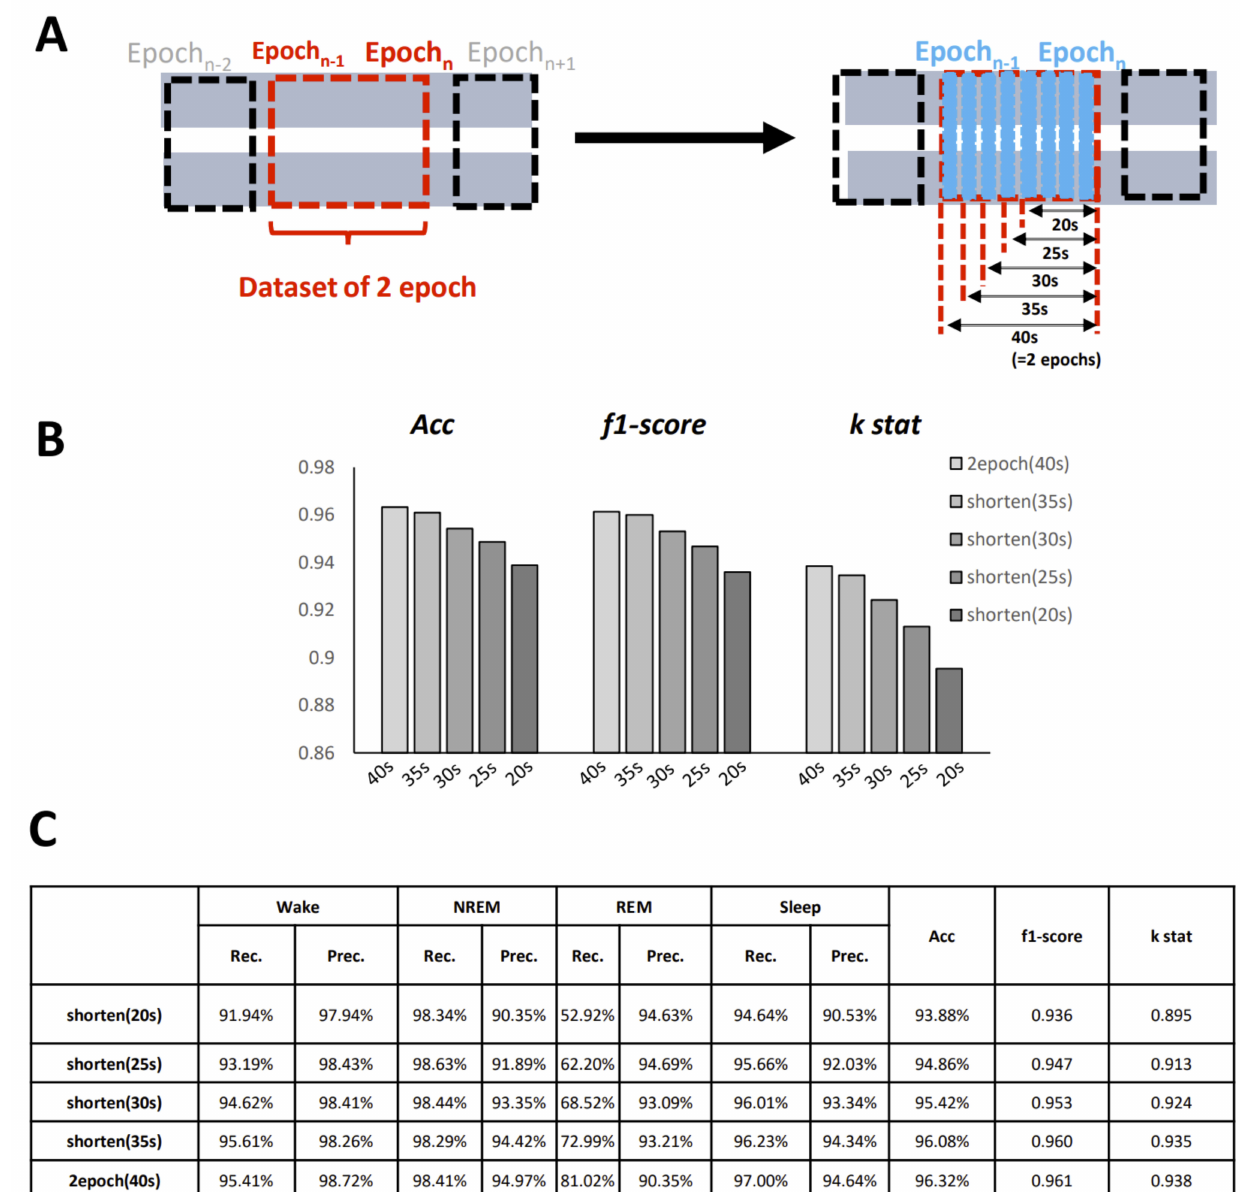
Figure 6. Effect of epoch length on the performance. ( A ) Schematic representation of the change in epoch length. ( B ) Comparison bar graph of three parameters between different epoch lengths. ( C ) Data table. Left side show the specific dataset with different length we used for